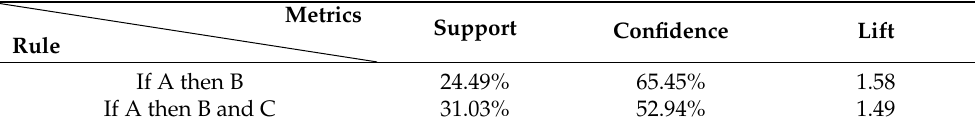
Table 2. Sum of A, B, and C elements repair in I–VI mining units.